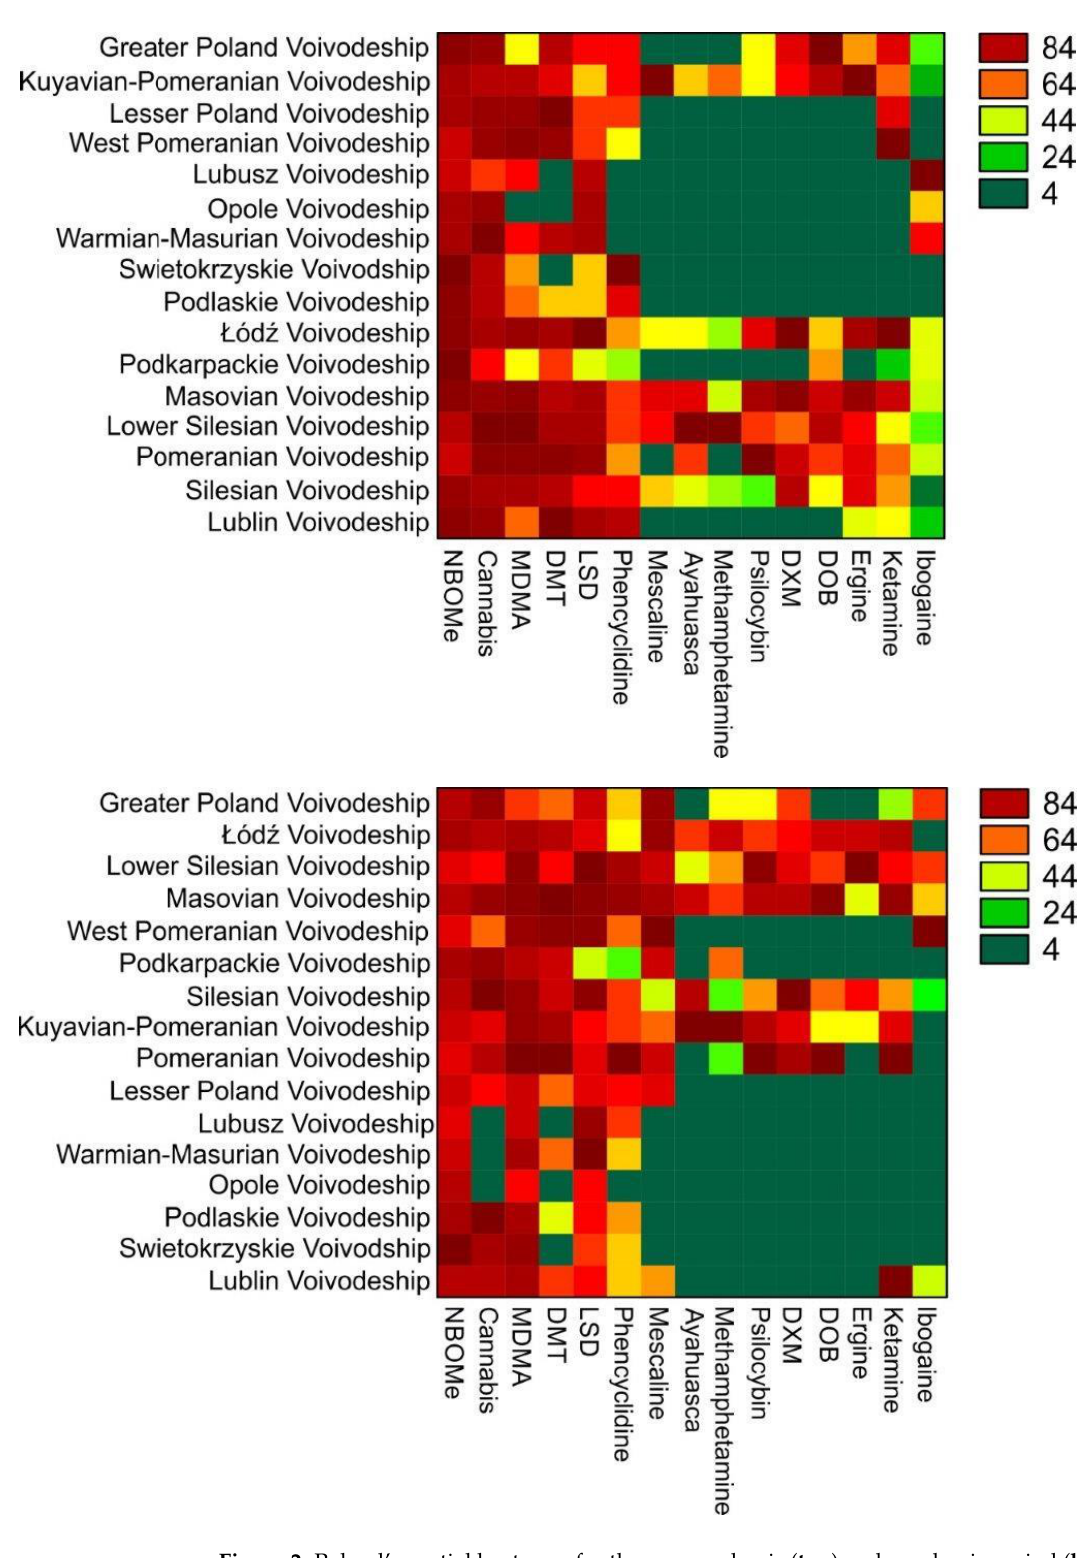
Figure 2. Poland ’ s spatial heat map for the pre-pandemic ( top ) and pandemic period ( bottom ). Figure 2. Poland’s spatial heat map for the pre-pandemic ( top ) and pandemic period ( bottom